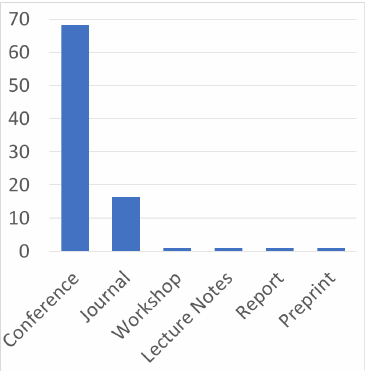
Figure 3. Distribution of publications by type.